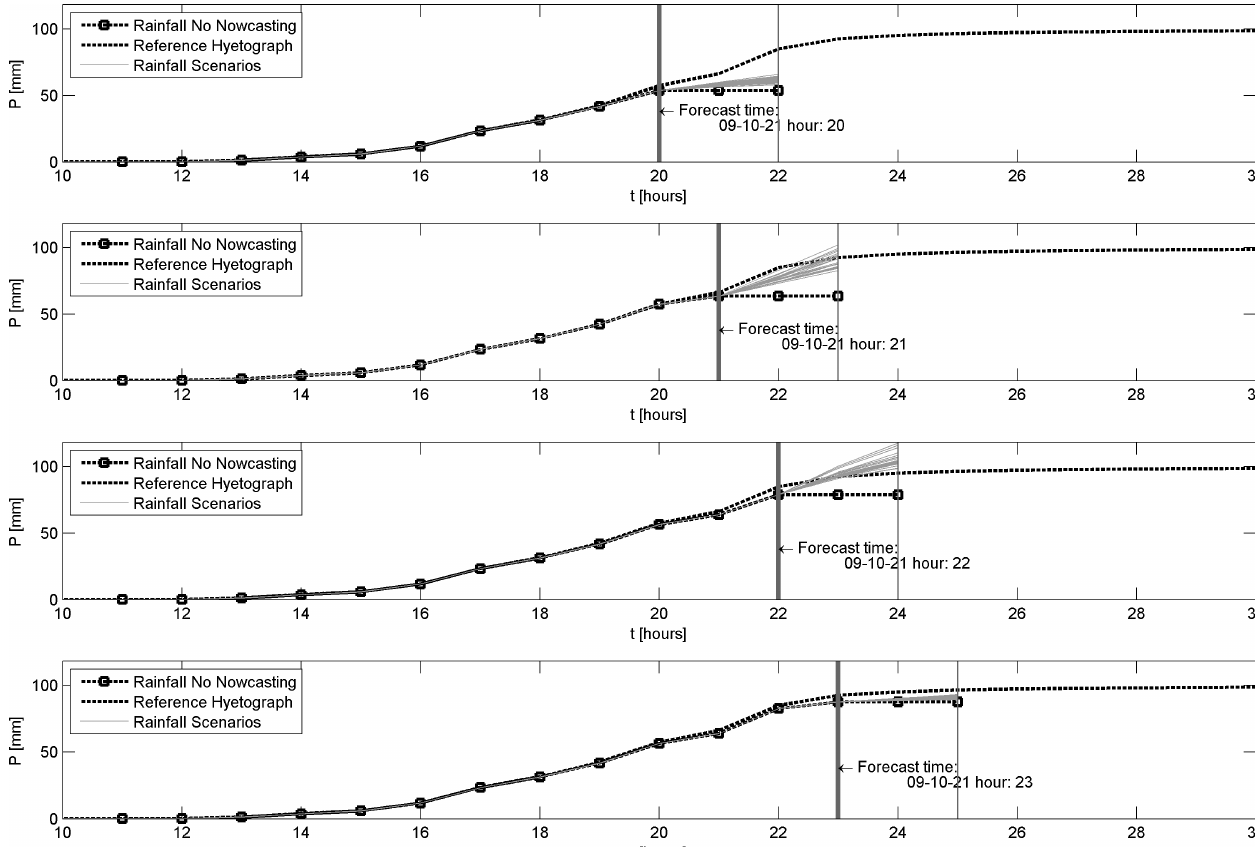
Fig. 7. Accumulated precipitation at basin scale for the case of the Entella Basin closed at Panesi (Area = 364km 2 ) . Event on 21 Oct 2009. Referring to Fig. 4, the close relationship between good performance of nowcasting algorithm and the good results of the framework in terms of discharge can be highlighted.